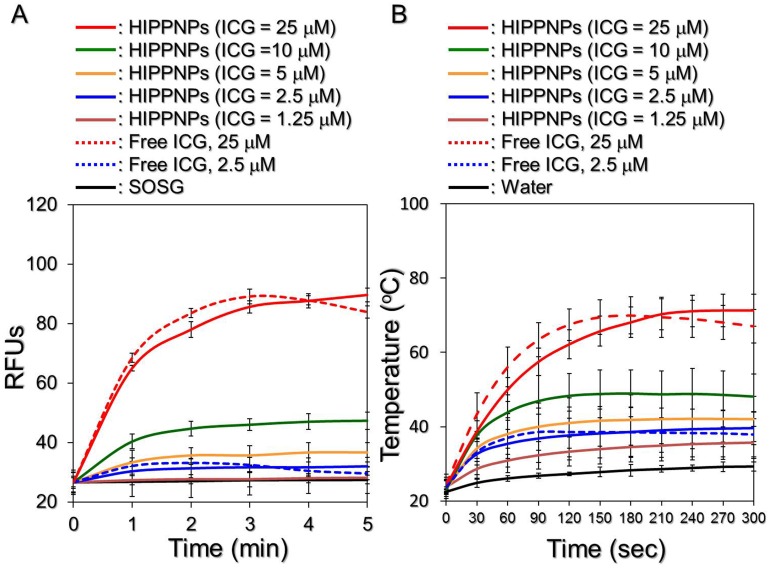
Yield of singlet oxygen and hyperthermia effect of HIPPNPs under NIR laser irradiation.Upon exposed to 808-nm CW laser with intensity of 6 W/cm2, both production of singlet oxygen (A) and variation of temperature (B) generated from the HIPPNPs with 0, 1.25, 2.5, 5, 10, and 25 μM ICG equivalent and freely dissolved ICG with concentrations of 2.5 and 25μM were measured every 60 (for yield of singlet oxygen) or 30 (for temperature change) sec for 5 min. The quantity of singlet oxygen was represented as the intensity of SOSG-induced fluorescence which was measured by spectrofluorometry with 488 and 525 nm of excitation and emission wavelength, respectively. The temperature at each time point was measured by using a digital thermometer. Values are mean ± SD (n = 3) in both examinations.